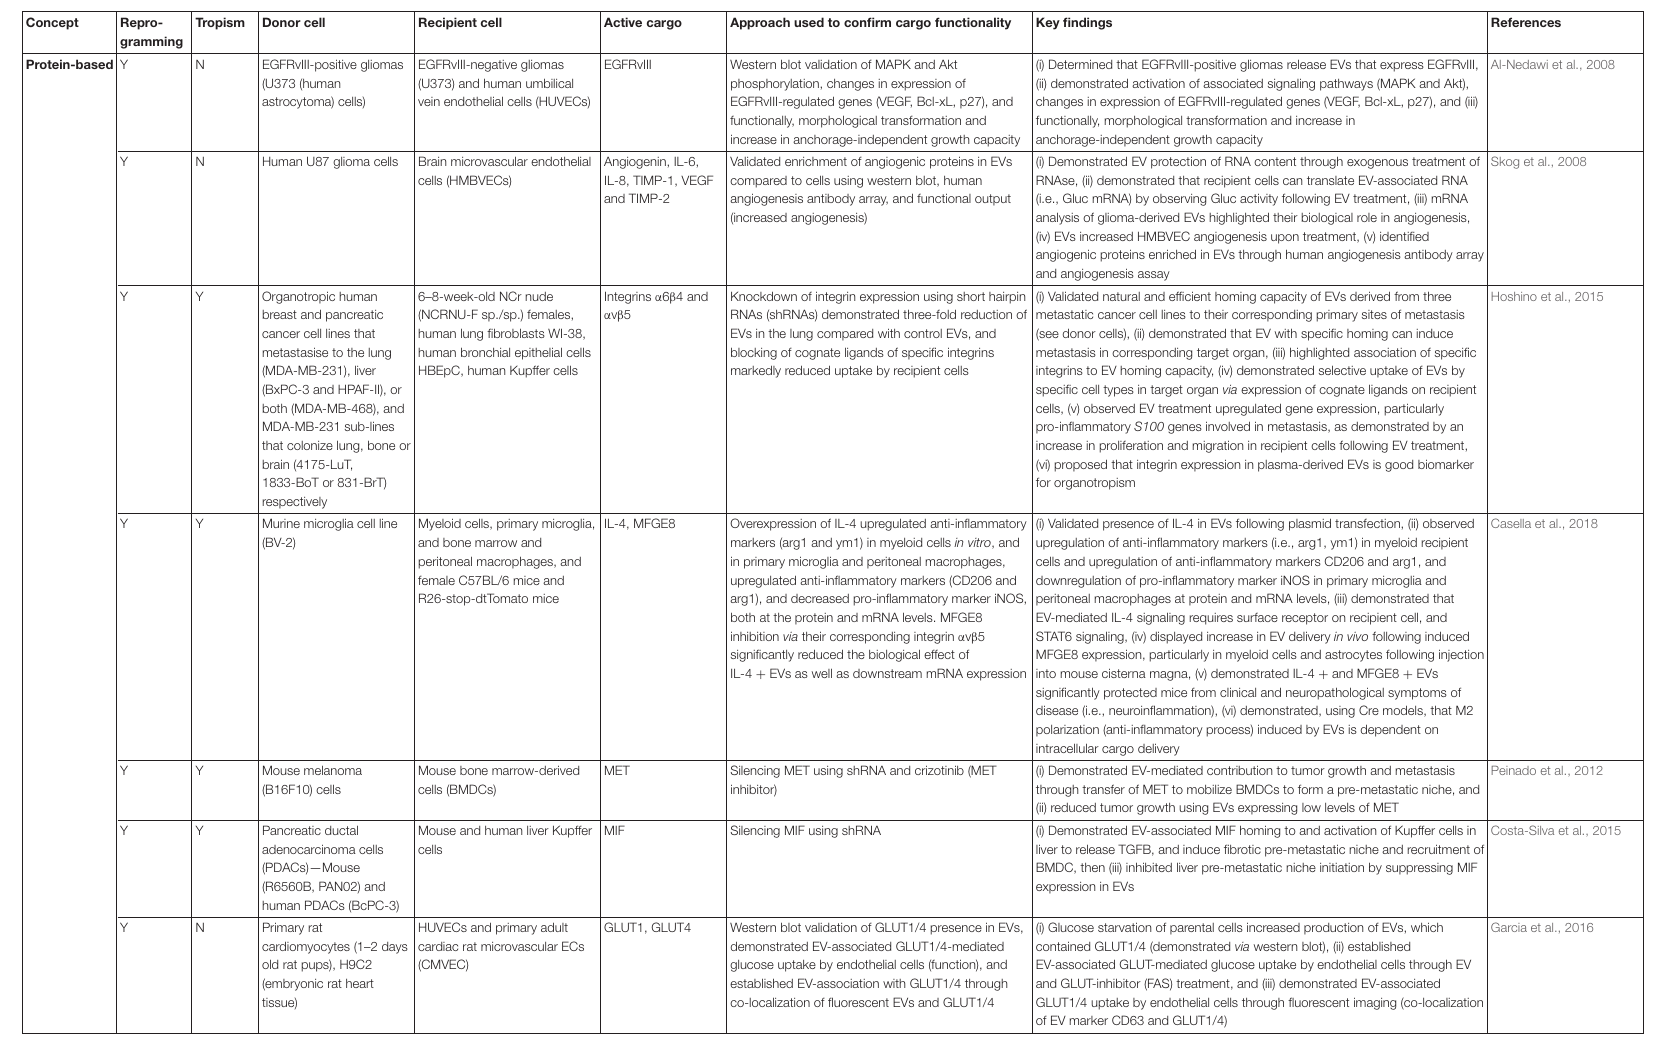
TABLE 2 | Evidence supporting the role of extracellular vesicle cargo in intercellular